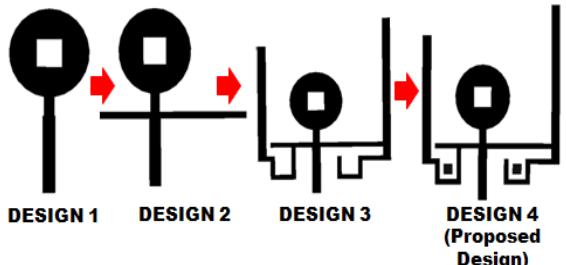
Figure 2. Design evolution steps of the proposed structure.